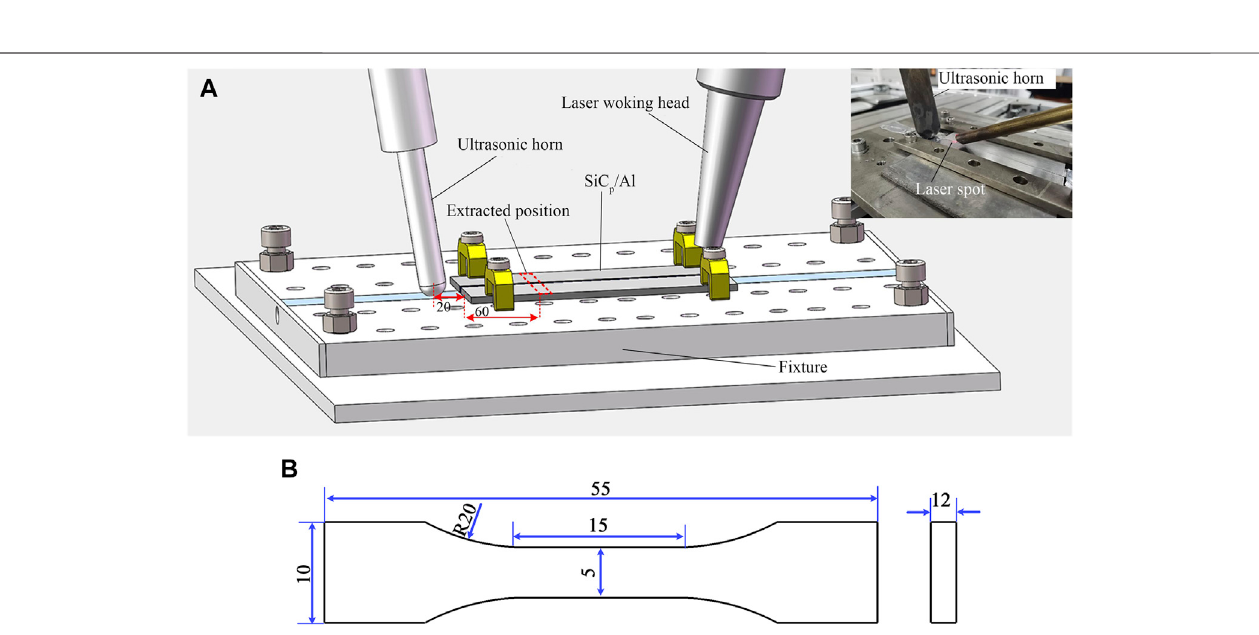
FIGURE 3 | (A) The platform of ultrasonic-assisted laser welding, (B) the dimensions of tensile specimen (mm).